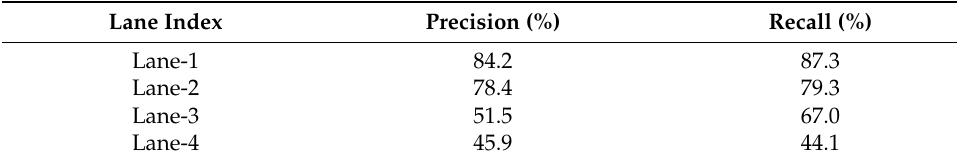
Table 3. Classification Result of ResNet18 (vision image).